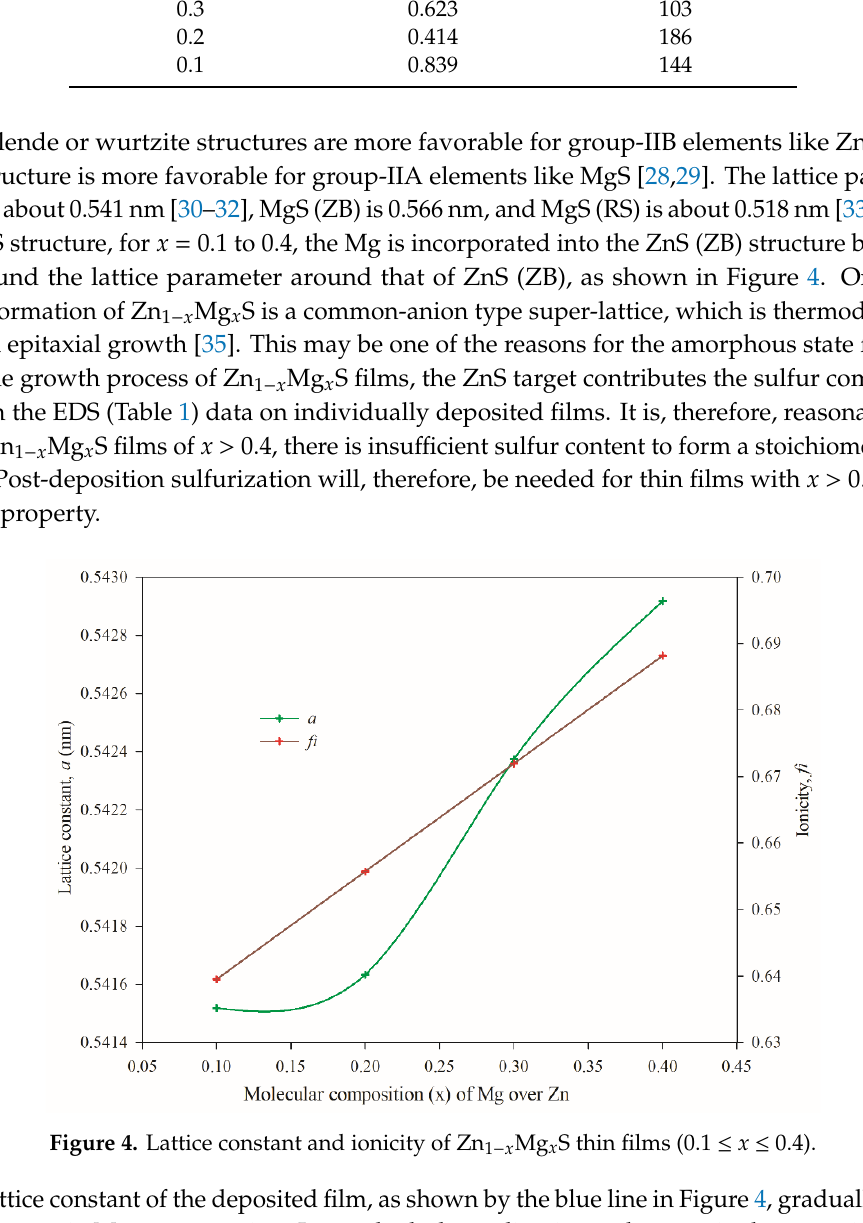
Figure 4. Lattice constant and ionicity of Zn 1-x Mg x S thin films (0.1 ≤ x ≤ 0.4).